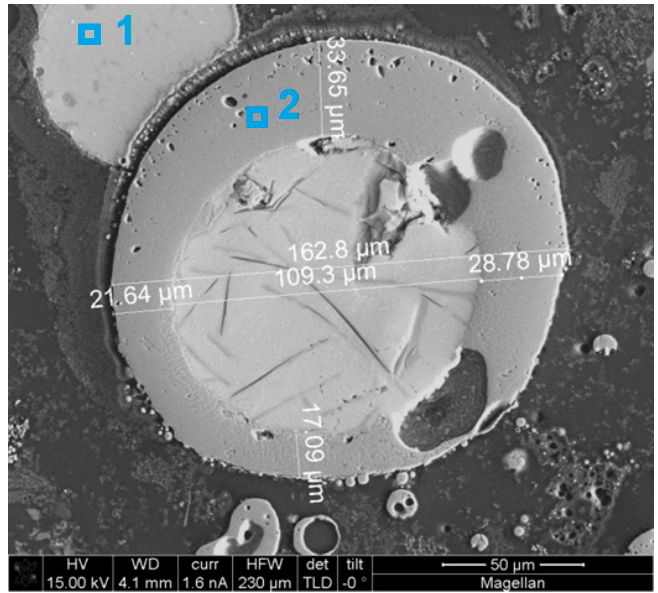
Figure 10. SEM image of particle cross-sections from residue following propellant test.